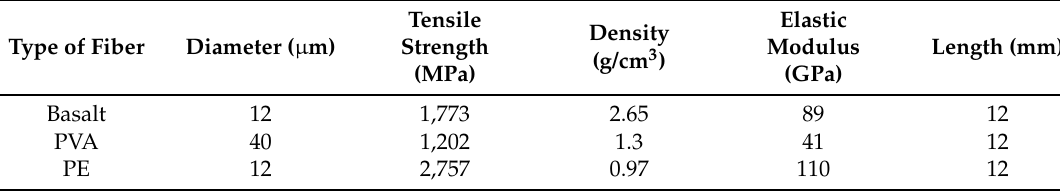
Table 2. Properties of fibers.